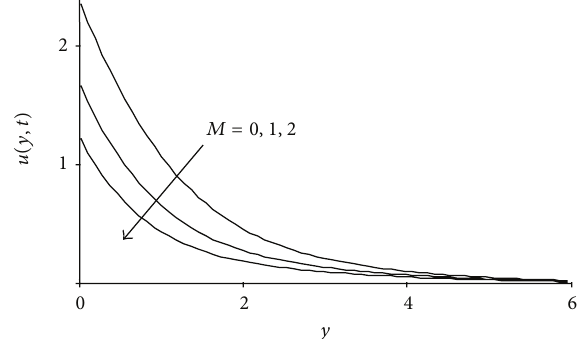
Figure 3: Velocity profiles for Pr eff = 0 . 350 ( 𝑁 𝑟 = 1, Pr = 0 . 7), = 0 . 7, 𝑡 = 1 . 2, and different values of Gm when the plate applies 𝐾 𝑝 constant shear stress 𝑓 = − 0 . 25.